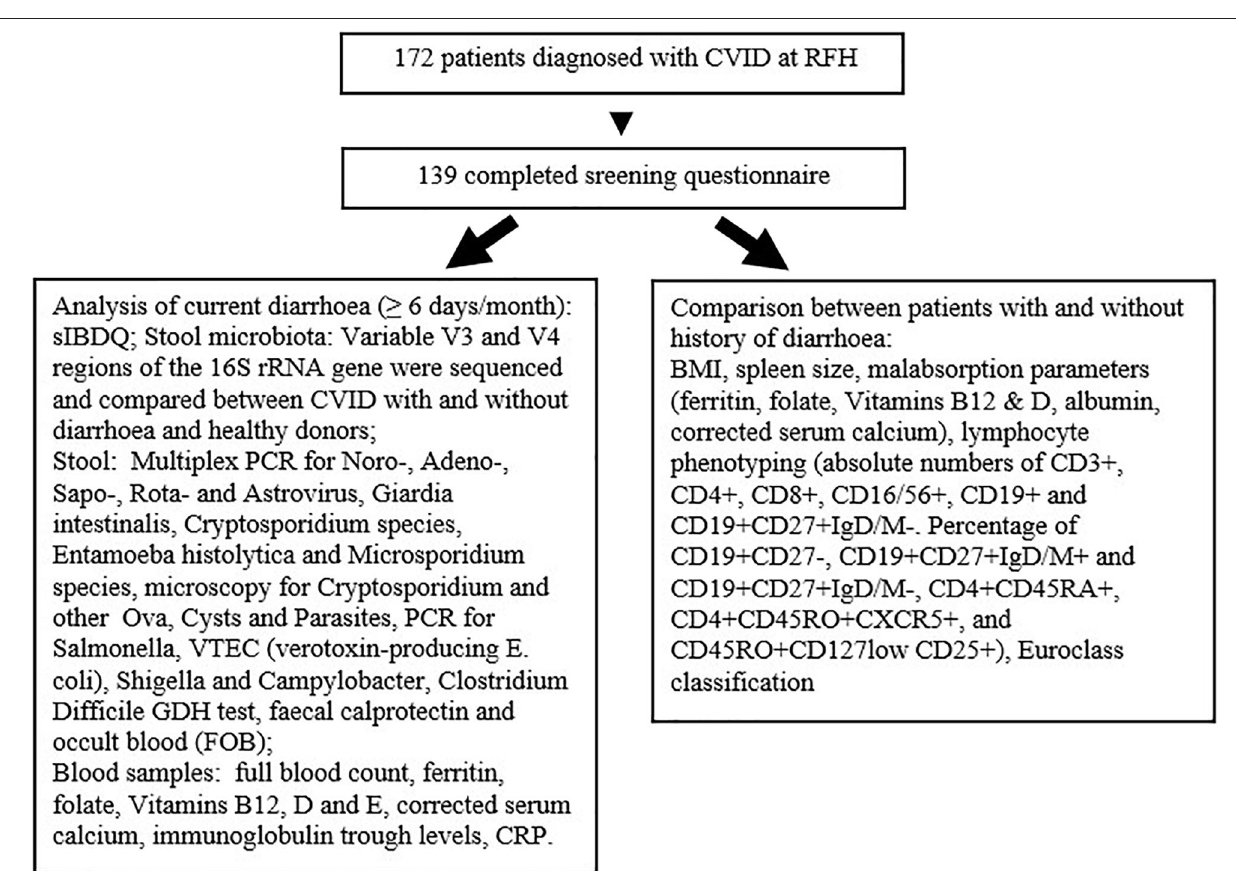
FIGURE 1 | Investigation schema for this